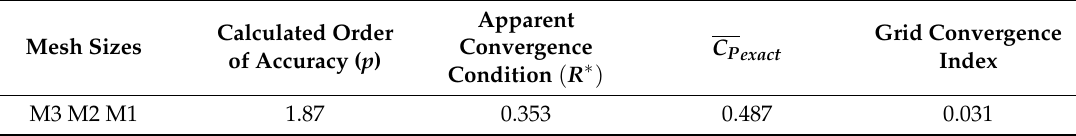
Table 2. Summary of the Richarson extrapolation.